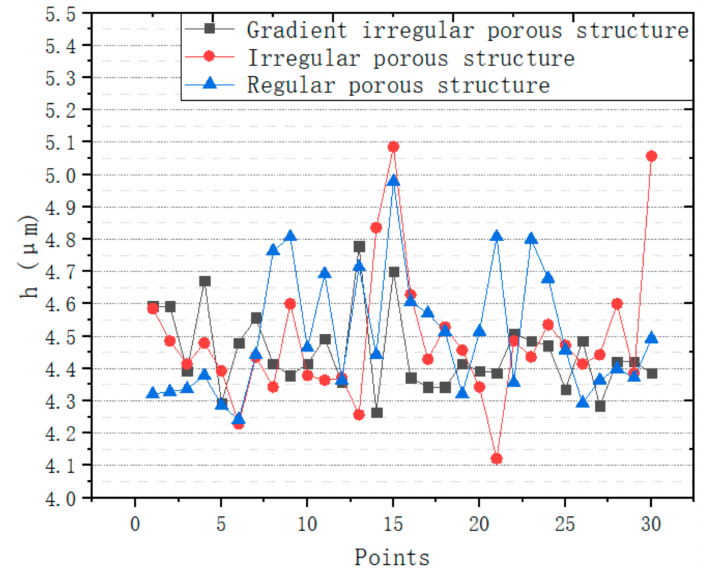
Figure 34. Indentation depth at 30 different